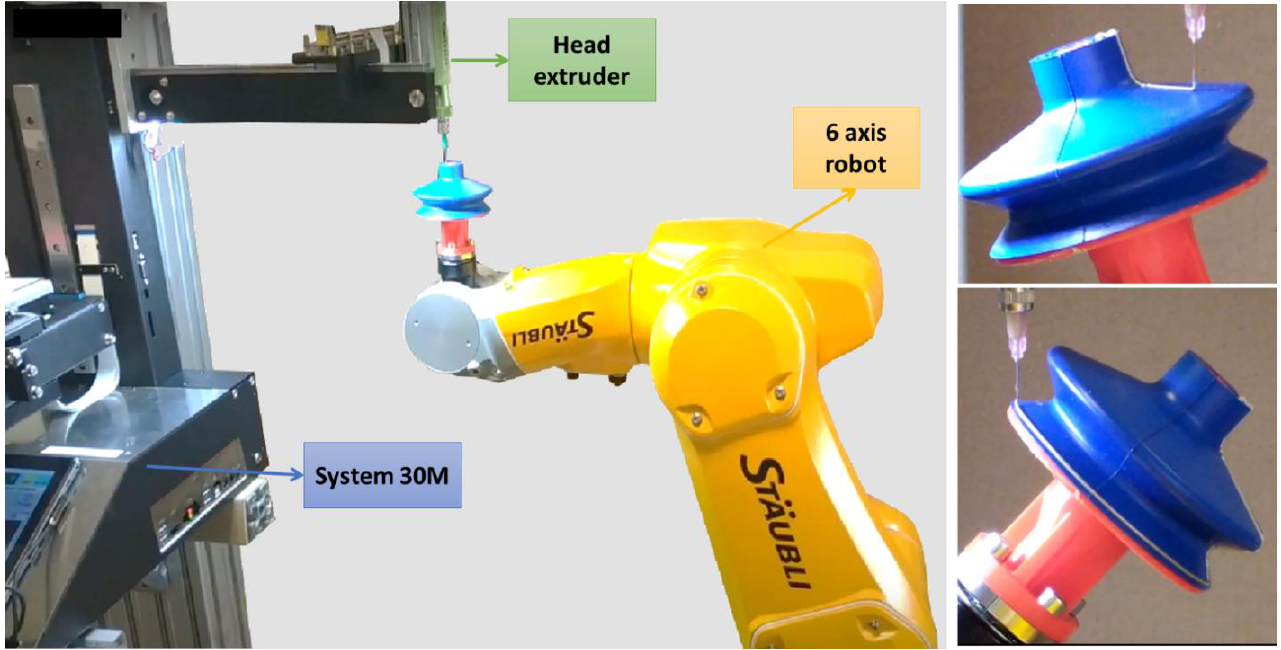
Figure 19. Advances in 3D printing process using a 6-DOF robotic arm.